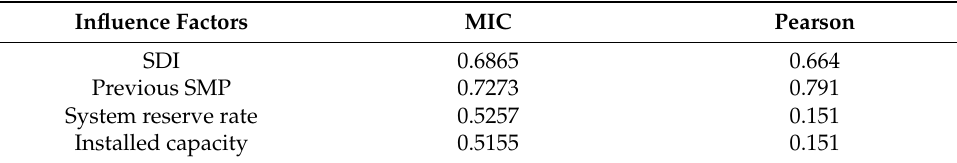
Table 1. Correlation between influencing factors and electricity price.